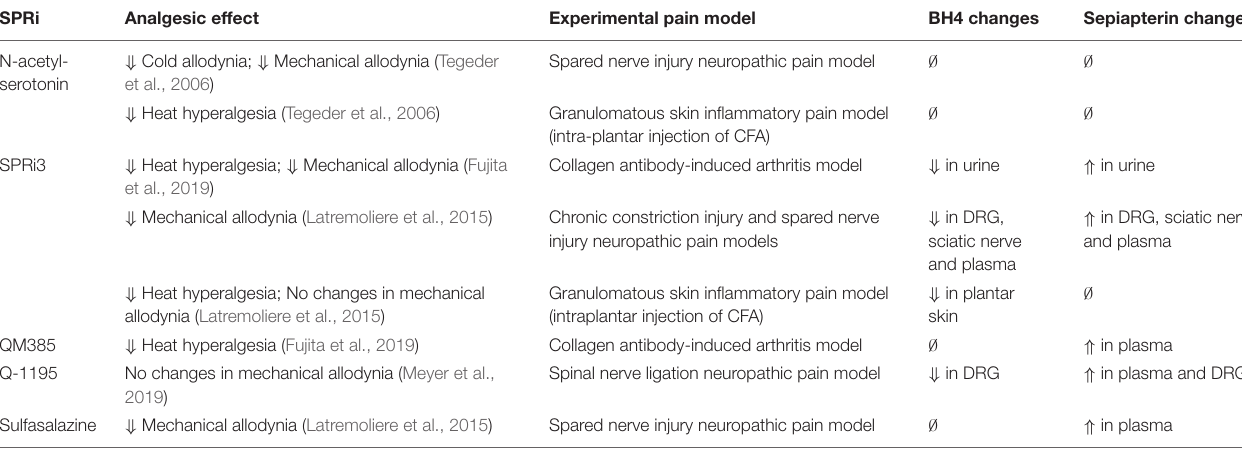
TABLE 2 | Analgesic effects, tetrahydrobiopterin (BH4) and sepiapterin changes for the main sepiapterin reductase inhibitors (SPRi). SPRi Analgesic